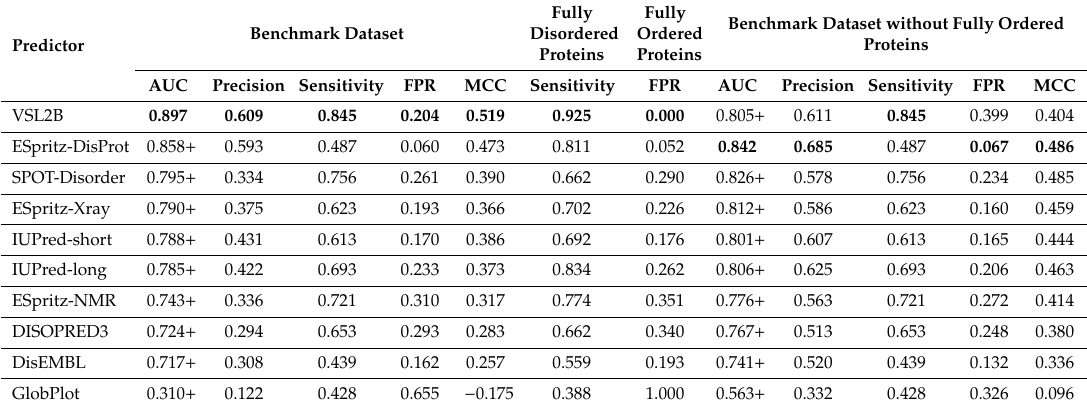
Table 3. Predictive performance on the new benchmark dataset. The table lists results on the complete benchmark dataset with 357 proteins, the set of 38 fully disordered proteins, the set of 38 fully structured proteins, and the benchmark dataset of 319 proteins that exclude the fully structured proteins. We quantify statistical significance of di ff erences in AUC between the best predictor (identified in